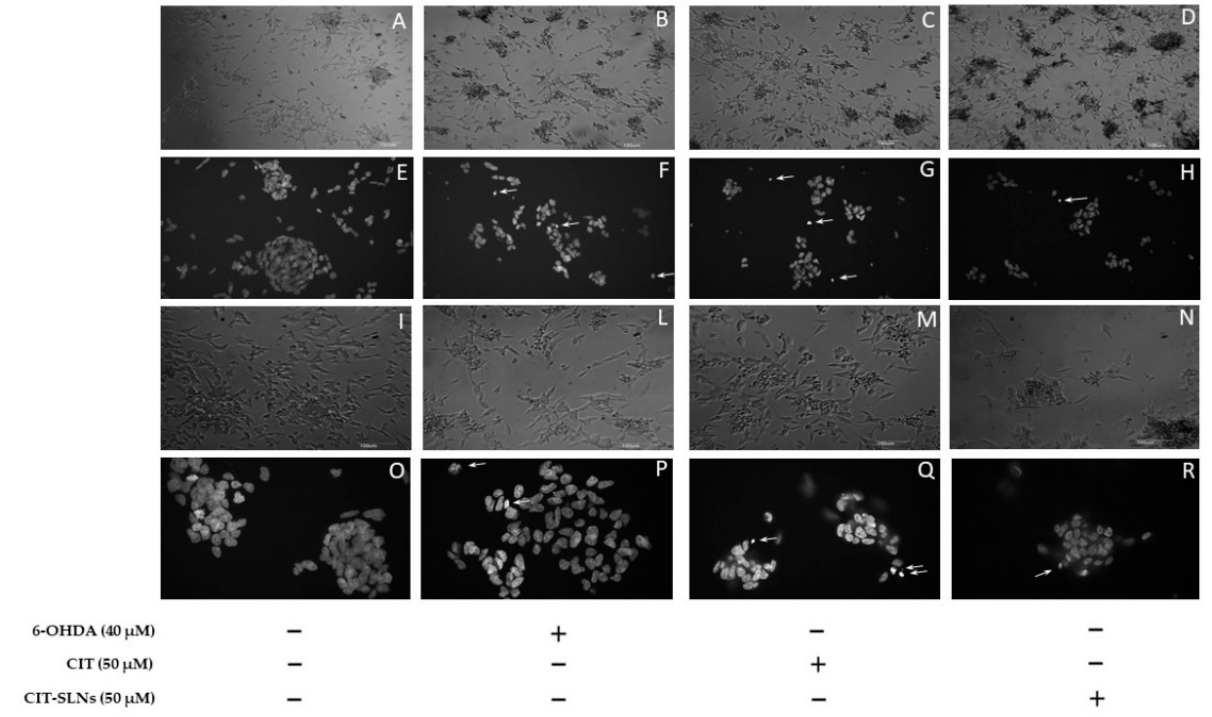
Figure 7. Morphological effects of CIT-SLN treatment. SH-SY5Y cells were treated with 6-OHDA (40 µ M) in the presence or absence of a pre-treatment (2 h) with free CIT or CIT-SLNs (50 µ M each one) and incubated for 24 h. Phase-contrast micrographs ( A – D , I , L – N ) or images of DAPI staining ( E – H , O – R ). Phase-contrast micrographs (first and third row) or images of DAPI staining (second and fourth row). Arrows point to nuclear fragmentation. Micrographs are representative of three different experiments. Magnification: 6,3 × ( A – D ); 10 × ( I , L – N ); 20 × ( E – H ); 40 × ( O – R ).